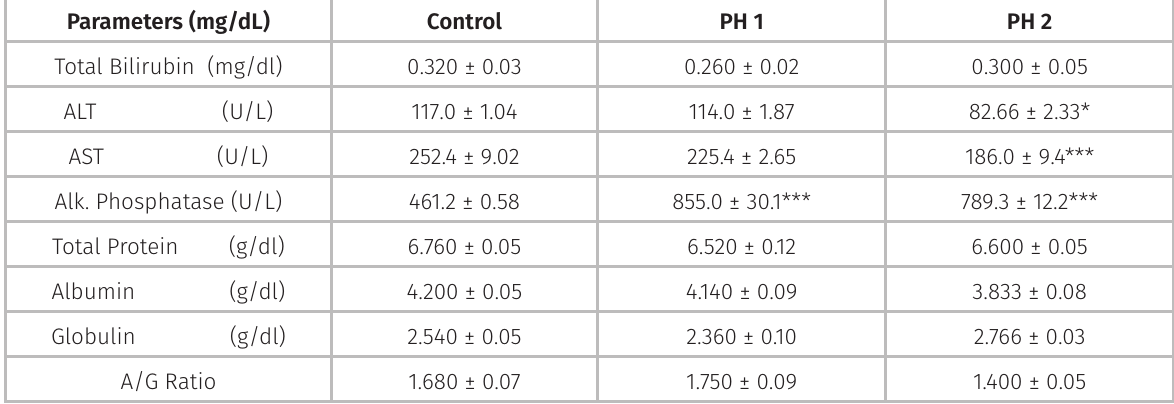
Table IV. Effects of polyherbal products on liver function test of rats in acute toxicity